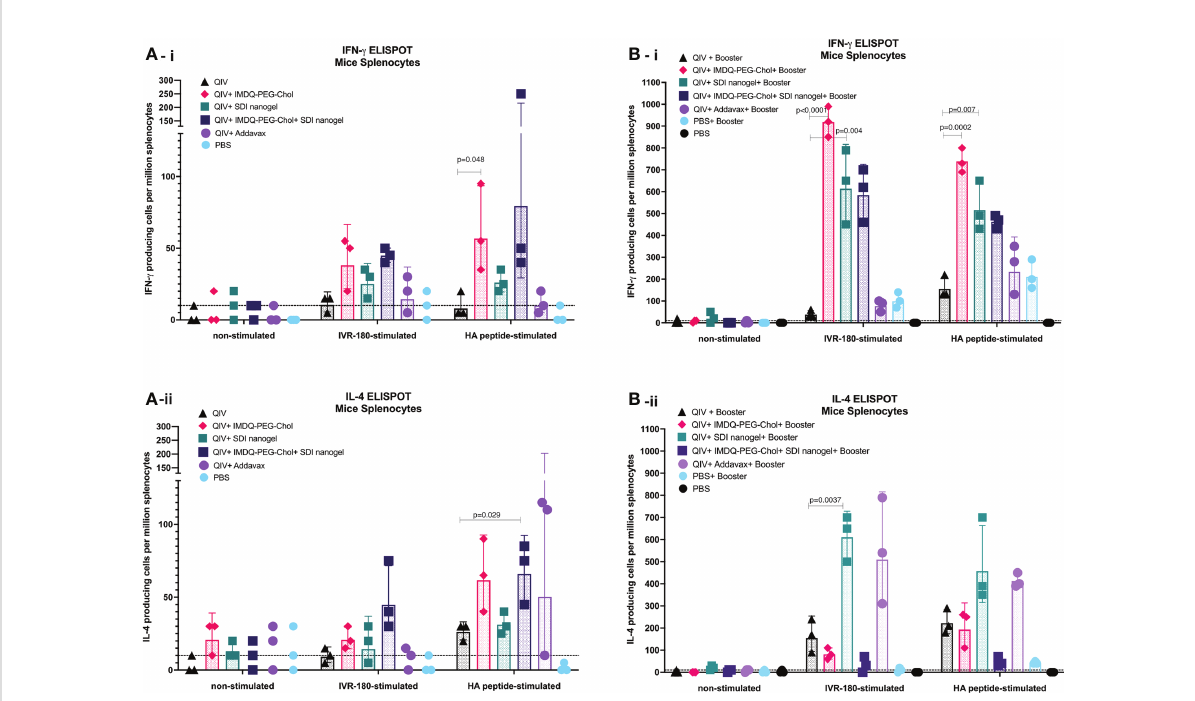
FIGURE 6 SDI+nanogel and IMDQ-PEG-Chol can effectively induce T cell responses in vaccinated animals: 6-8 weeks BALB/c mice were vaccinated with QIV with and without SDI+nanogel and/or IMDQ-PEG-Chol and spleens were harvested 10 days post-prime (A) and post-boost (B) to examine the T cell activation by IFN- g (A-i, B-i) and IL-4 (A-ii, B-ii) ELISPOTs upon restimulation with H1-HA short-overlapping peptides. The results are represented as IFN- g or IL-4 producing cells per million splenocytes (geometric mean ± geometric SD) for n=3 animals per group. The cut-off was set to 10 which indicates one spot in any well. Statistical analysis was performed using two-sided unpaired T test. P values are calculated in reference to respective unadjuvanted QIV